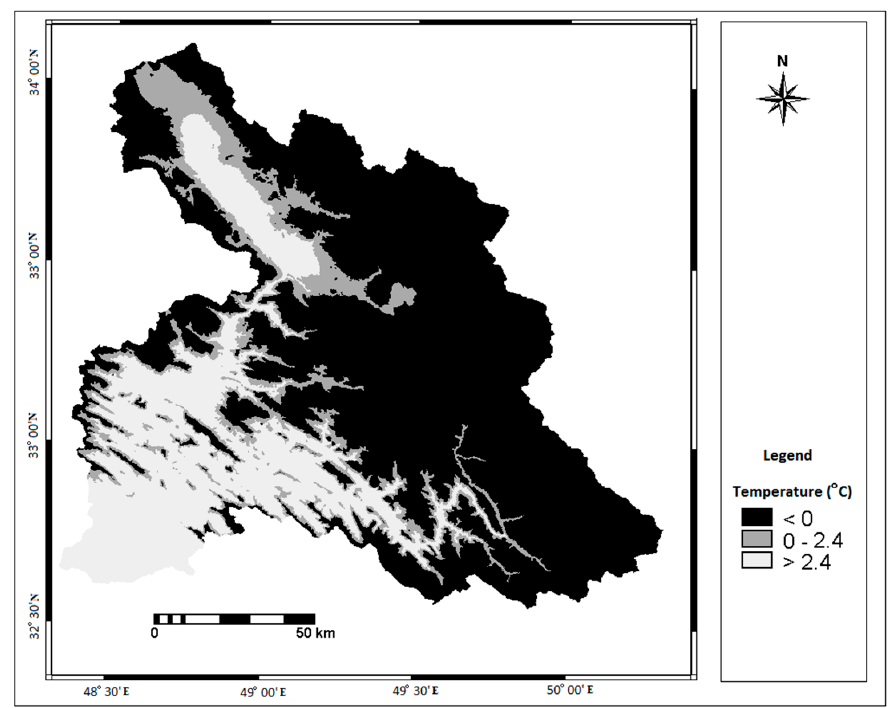
Figure 3. Potential areas for snow persistence ( T < 0 °C), snowfall (0 < T < 2.4 °C) and snowmelt ( T > 2.4 °C) in Dez Basin in February (for the period of 1974–1999).